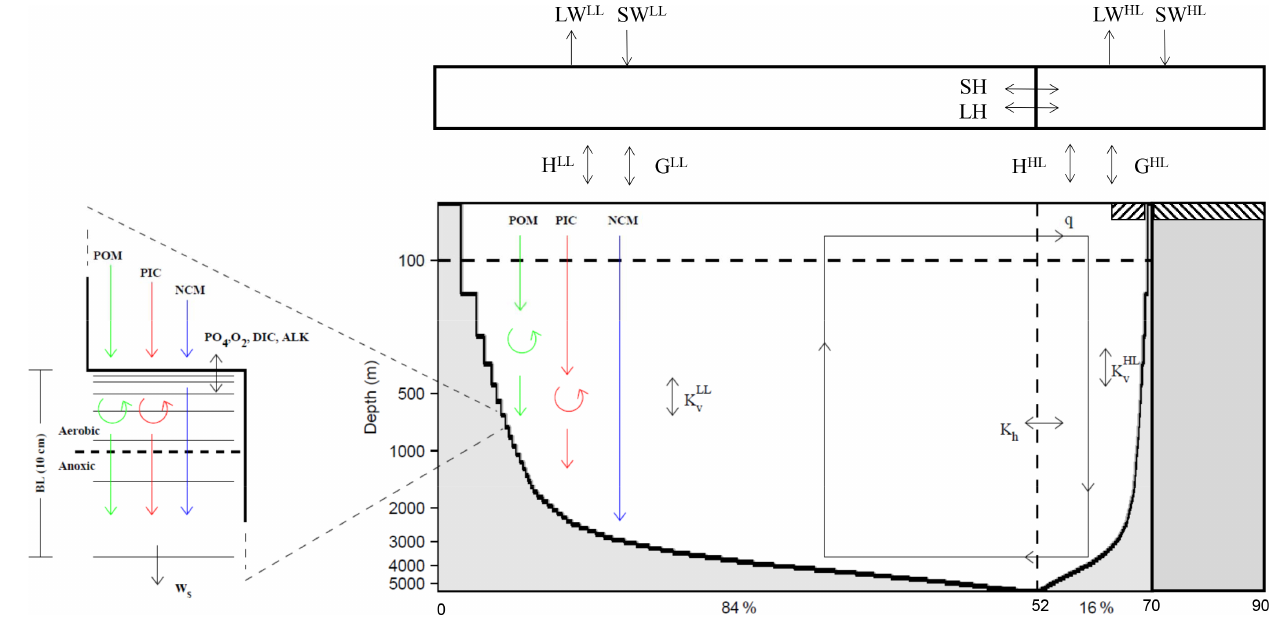
Figure 3. Atmosphere, ocean and ocean sediment configurations. Temperatures of low–mid (LL) and high (HL) latitude atmosphere sectors derive from energy balance forced by yearly-mean insolation (SW), outgoing longwave radiation (LW), meridional transports of sensible (SH) and latent (LH) heat, and air–sea heat exchange (H). In combination with the simple sea ice and snow (hatched bars) parameterizations, the model includes the ice/snow albedo feedback and the insulating effect of sea ice. Meridional variations in atmospheric temperature are represented by a second order Legendre polynomial in sine of latitude, adjusted to fit sector mean temperatures. Temperatures and gradients at the 52 ◦ dividing latitude from this meridional profile are used to calculate sensible heat, latent heat and water vapor transports. The atmosphere exchanges heat and gases (G) with the ice-free part of the ocean. Gases are well-mixed in the atmosphere and their concentrations follow from internal sinks, exchanges with ocean surface layers and the land biosphere and input/outputs from weathering and lithosphere outgassing. Both LL and HL ocean sectors are continuously stratified with 100m vertical resolution to maximum depths of 5500m and each sector has a bottom topography based on real ocean depth distribution. Model ocean circulation and mixing are indicated by the black arrows and associated circulation/mixing type labels (see main text). Model ocean biogeochemical cycling is indicated by the colored arrows (acting in both sectors but for simplicity only shown for LL sector) and associated matter (particulate organic, POC; biogenic carbonate, PIC; and inert mineral, NCM). Each of the 110 model sediment segments has an area set by the real ocean depth distribution and consists of a 10cm thick, bioturbated layer divided into seven sublayers. Sediment biogeochemical cycling is indicated by colored arrows and associated matter. Exchange of dissolved species at the sediment–water interface is also indicated. The sedimentation rate down out of the bioturbated layer ( w s ) is calculated from mass